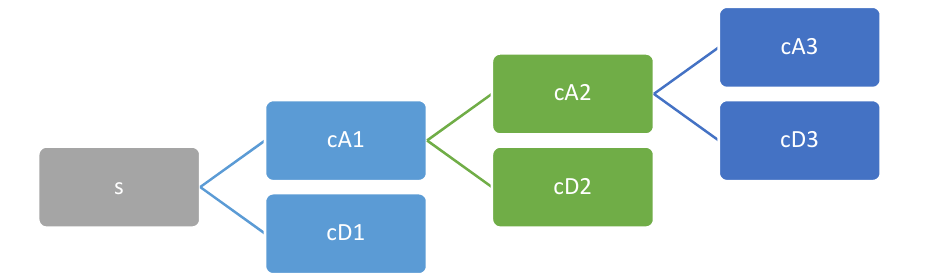
Figure 4. Wavelet decomposition tree.